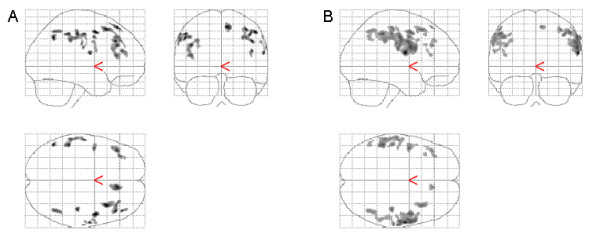
Group comparison of unmodulated and modulated grey matter segments. Group differences of grey matter densitiy reductions (unmodulated data, A) and regional grey matter volumes (modulated data, B) in ALS patients versus controls are displayed within a 'glass brain' view. Note that only the comparison of modulated data survived the correction for multiple comparisons specified a priori. Images are displayed at p = 0.001, uncorrected, extended threshold 100 voxels and shown in neurological convention.